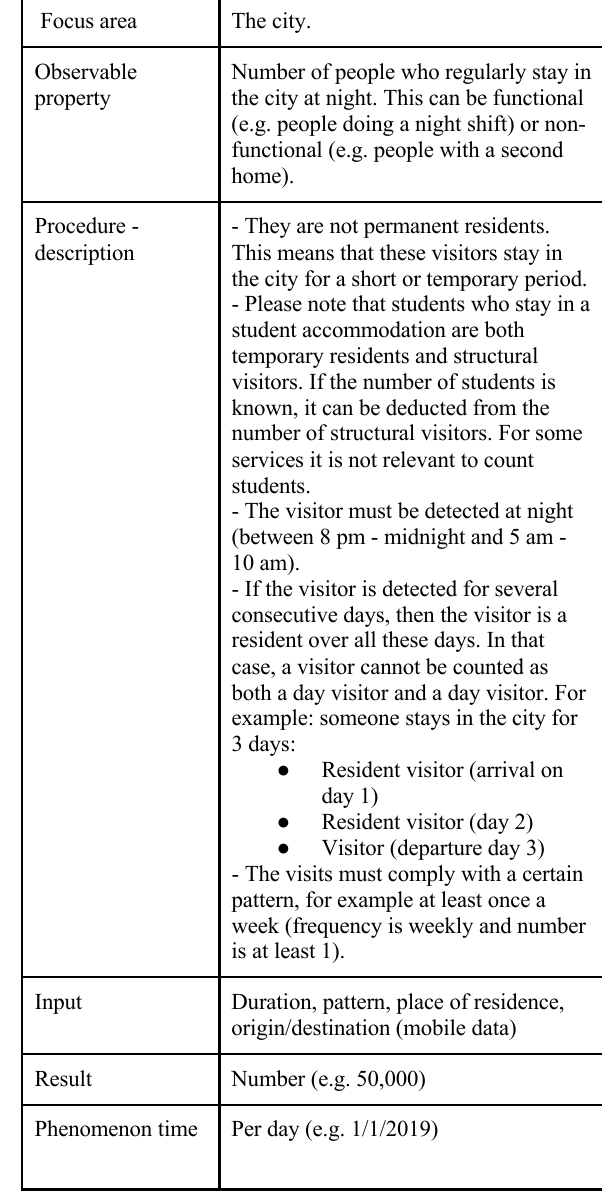
Table 5. Description of the profile “Structural staying